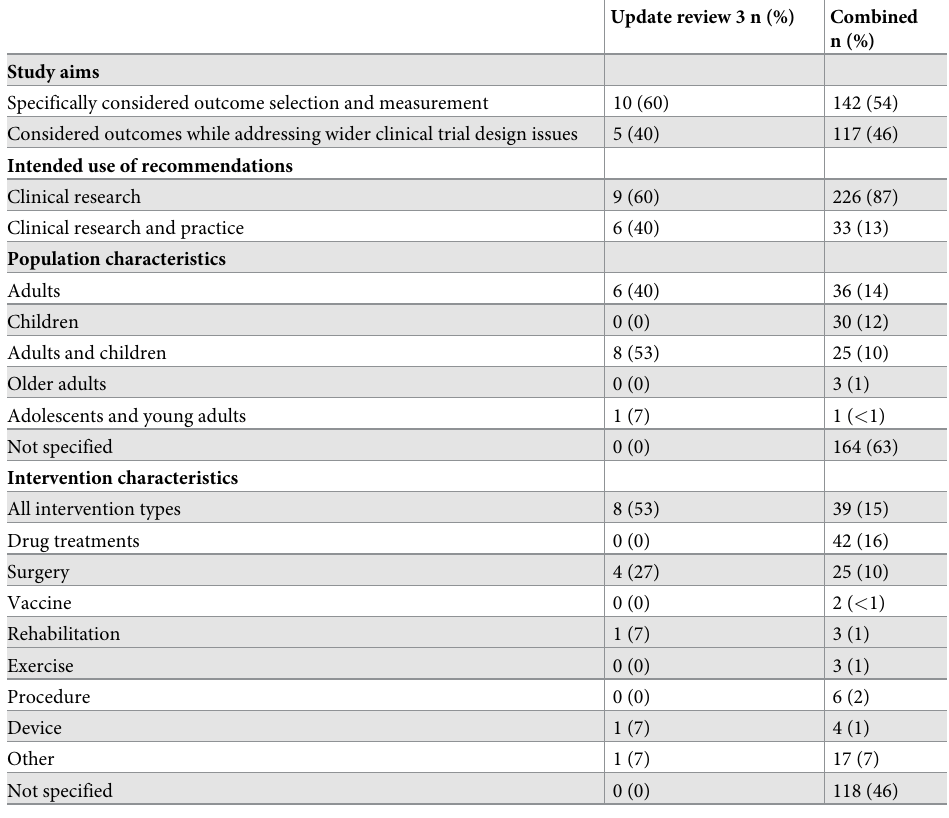
Table 2. The scope of included studies (n = 259).